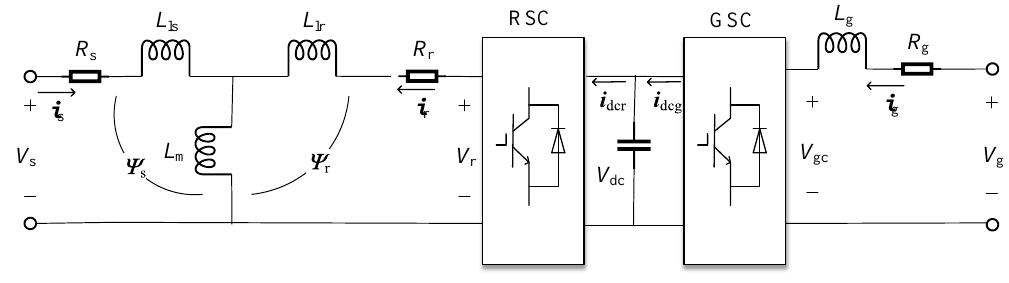
Figure 1. The equivalent circuit of the DFIG.